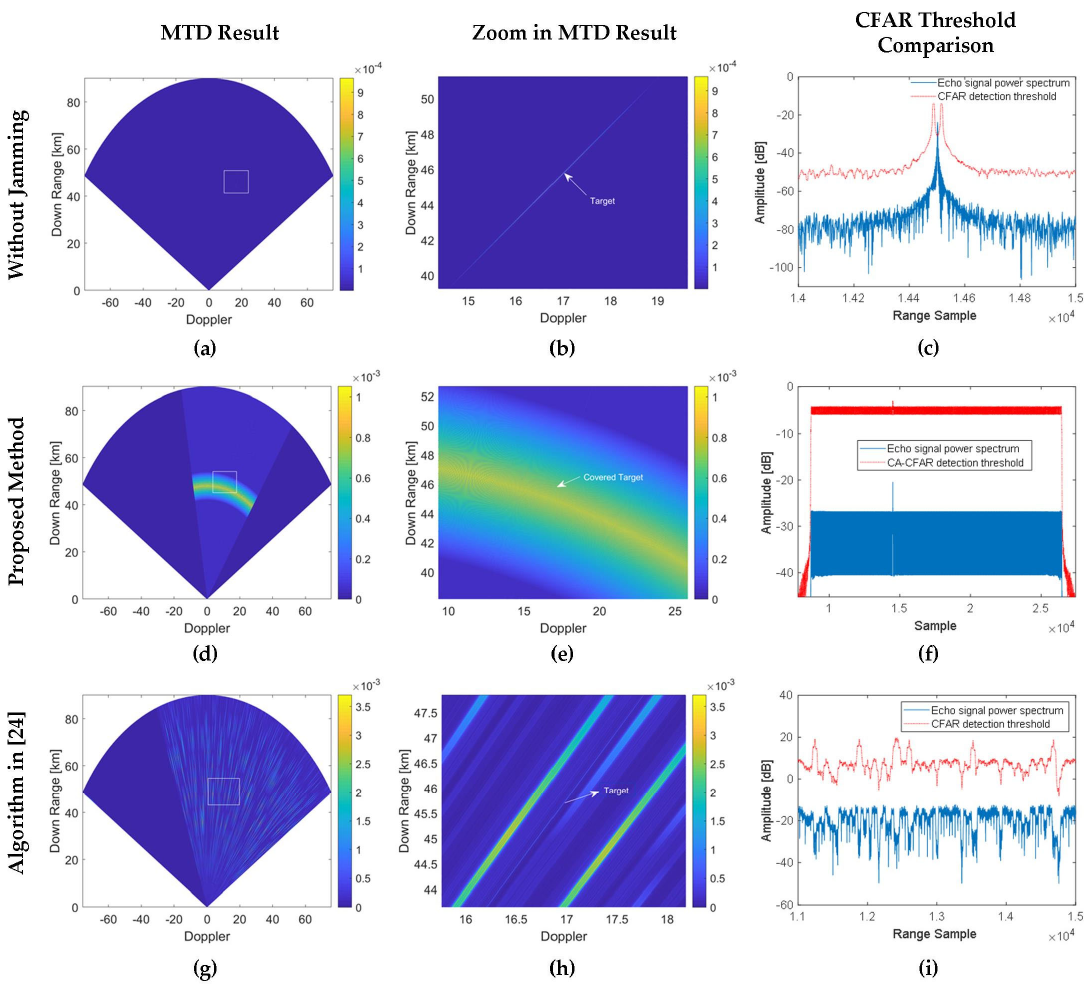
Figure 14. The results of multi ‐ false ‐ target jamming under the MTD and CFAR. The leftmost column ( a , d , g ) is the results of target echoes processed by MTD under three cases; the second column ( b , e , h ) is zoom in MTD results; the third column( c , f , i ) is the comparison of CFAR threshold.